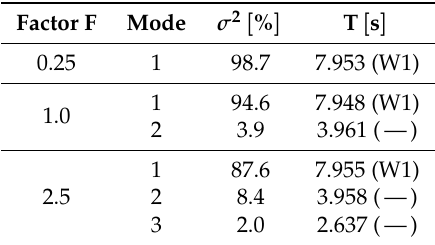
Table 7. Results of the PCA obtained for nonlinear wave propagation of the monochromatic W1 case with different F factors: Next to the retrieved period, the corresponding wave field is indicated (when applicable). Factor